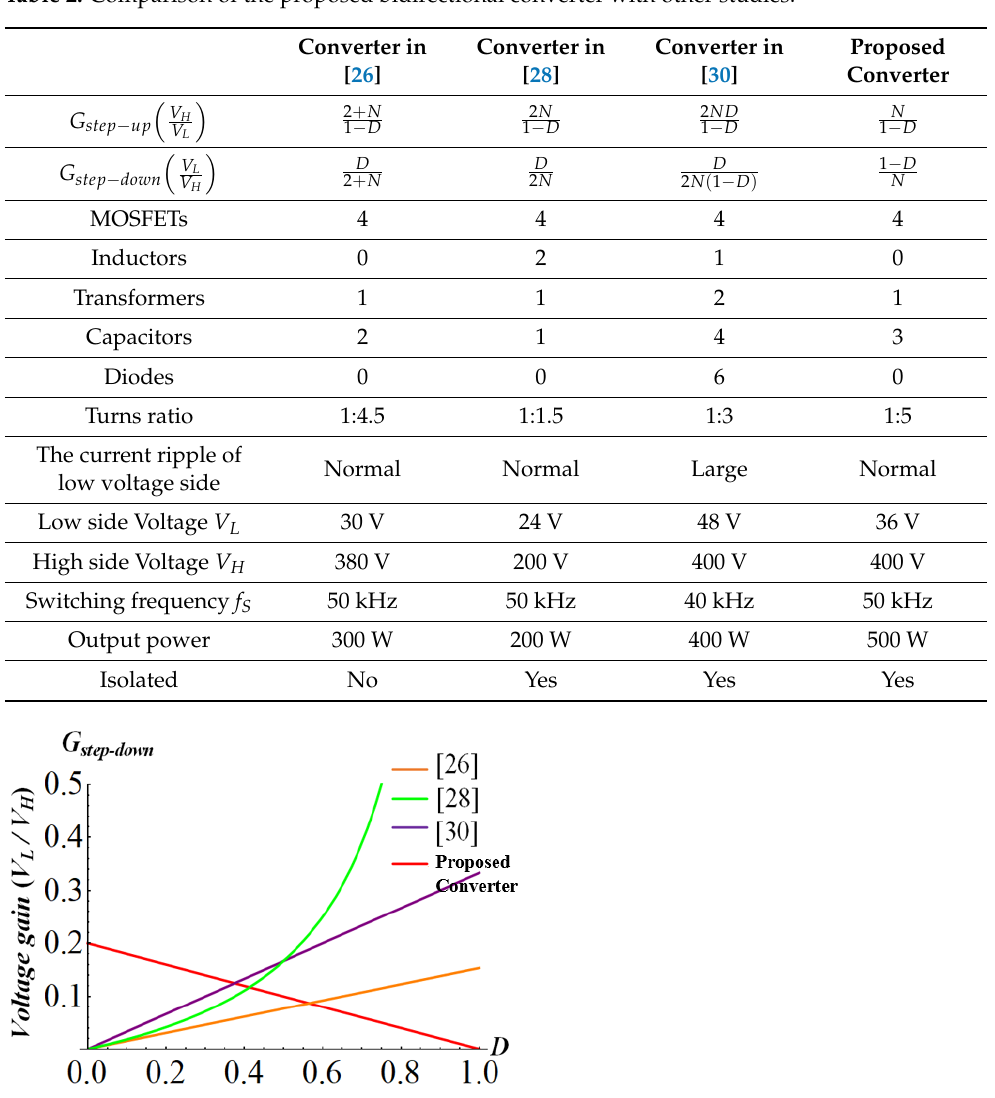
Figure 20. Comparison of voltage gains in step-down mode of the proposed converter and the converters in [26,28,30].